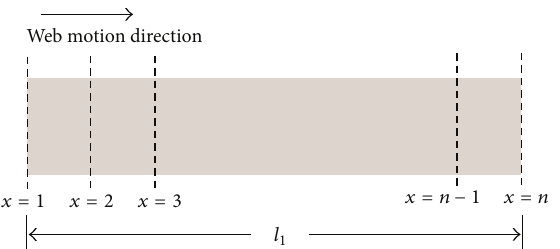
Figure 9: Finite difference grid applied to the web in the first drying zone.